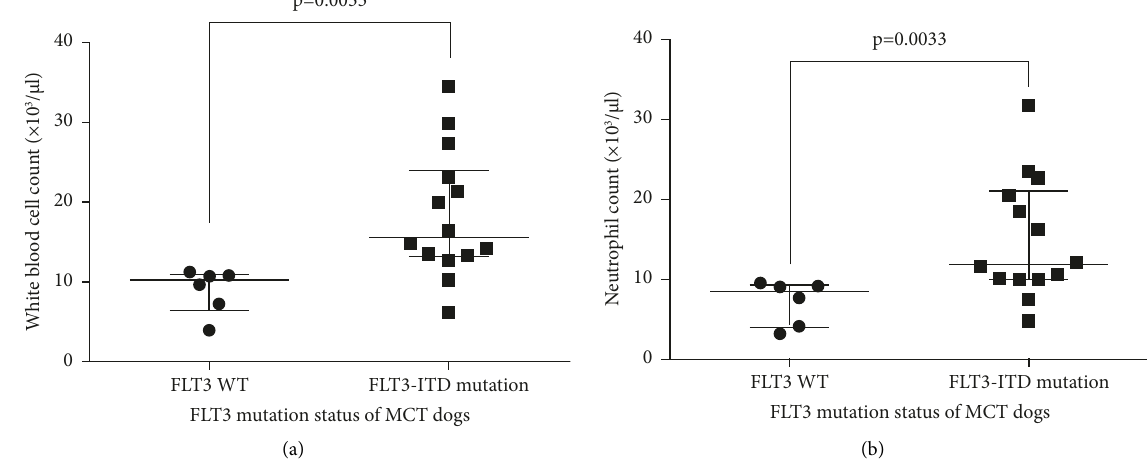
Figure 2: Difference in white blood cell (WBC) (a) and neutrophil (b) counts between. FLT3- WTand ITD mutation groups of MCTdogs. Data are presented as dot plots analysis of total WBC counts (a) and neutrophil counts (b) of canine MCTpatients between FLT3-WT ( n � 4) and FLT3-ITD mutation of JM domain ( n � 16).